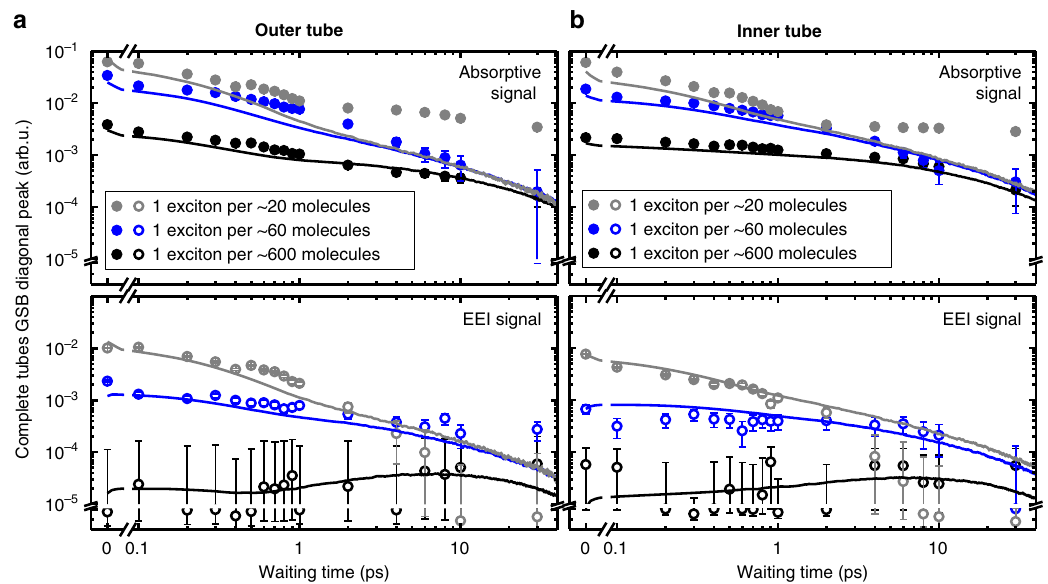
Fig. 4 Absorptive and EEI transients of both layers of complete nanotubes. Log – log plots of the absorptive (upper panels, solid circles) and EEI (lower panels, open circles) GSB/SE transients for (a) outer and (b) inner tube diagonal peaks at different exciton densities. The transients were obtained by integrating the signal in the rectangular regions of interest shown in Fig. 2b. The panels are drawn with the same scaling to emphasize their direct comparability, as both are derived from the same signal. The error bars refer to the detection noise level in the experiment (Supplementary Note 3). The solid lines depict the results from Monte Carlo simulations of the exciton dynamics on isolated inner tubes. The amplitude (vertical) scaling between experimental and simulated data is preserved, i.e., for each signal (absorptive and EEI) a single scaling factor was used for all simulated transients. The sign of the EEI responses was inverted for the ease of comparison. Deceleration of the transient dynamics at T > 2 ps for the highest exciton density (1 exciton per ~20 molecules) is caused by transient heating of the nanotubes and a few surrounding water layers as a result of the energy released by exciton annihilation events (Supplementary Note 8 and Supplementary Figs. 17 and 18)